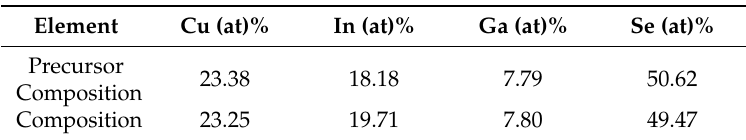
Table 1. The synthesized CIGS have a ratio of 0.9:0.75:0.30:1.90 (Cu:In:Ga:Se), which is close to the precursor composition. Table 1. The chemical composition measured by X-ray fluorescence ( XRF) of the CuInGaSe 2 (CIGS) Table 1. The chemical composition measured by X-ray fluorescence (XRF) of the CuInGaSe 2 (CIGS) nanoparticles prepared using the solid phase synthesis process. nanoparticles prepared using the solid phase synthesis process. Element Cu (at)% In (at)% Ga (at)% Se